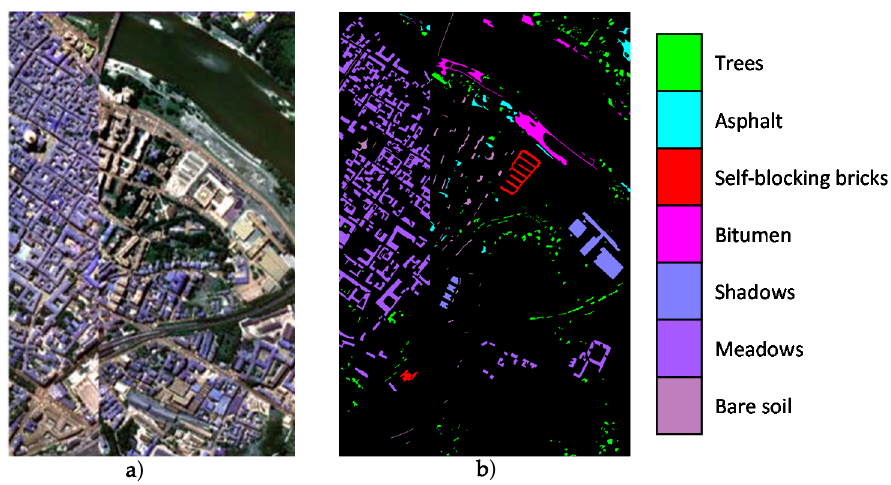
Figure 3. (a) False-color image of Pavia University dataset. (b) Ground truth of Pavia University dataset.